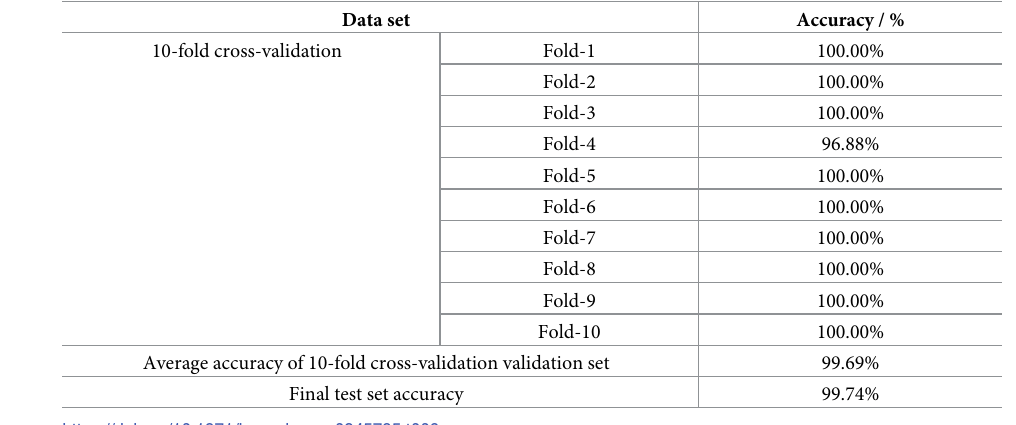
Table 6. 10-fold cross-validation training